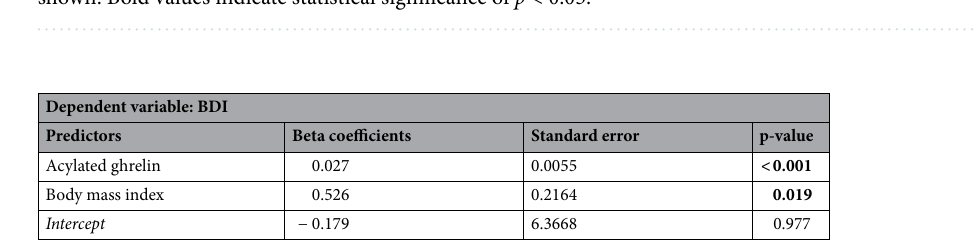
Table 4. Pearson correlation coefficients Only the variables showing at least one significant correlation are shown. Bold values indicate statistical significance of p < 0.05.